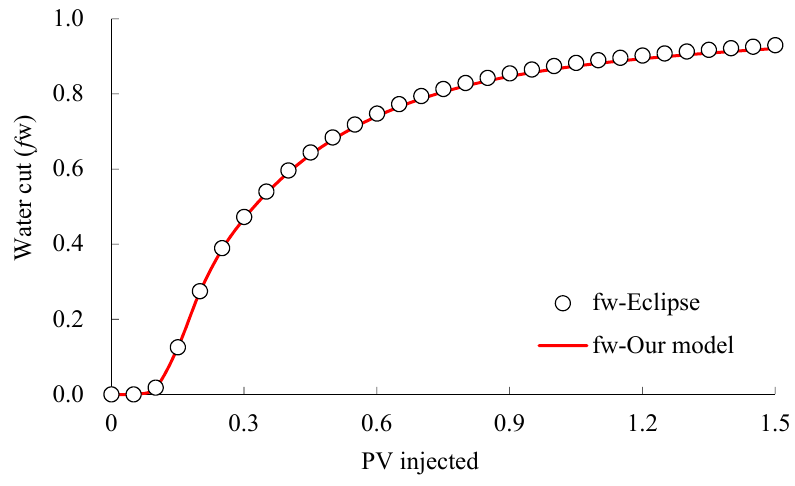
Figure 10. Water cut variation of staged fractured horizontal well.